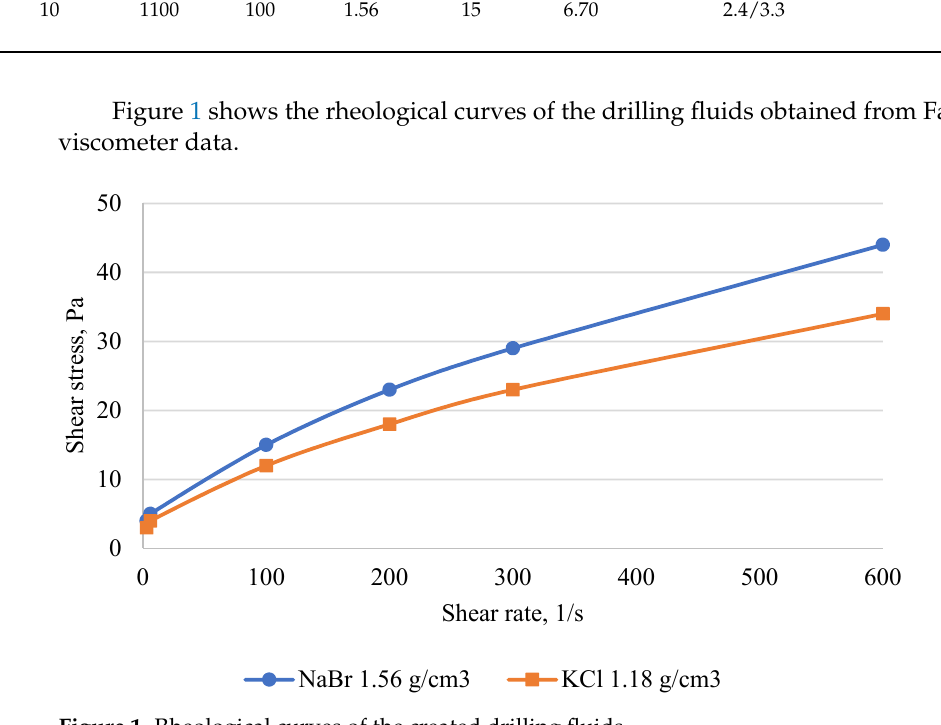
Figure 1. Rheological curves of the created drilling fluids.